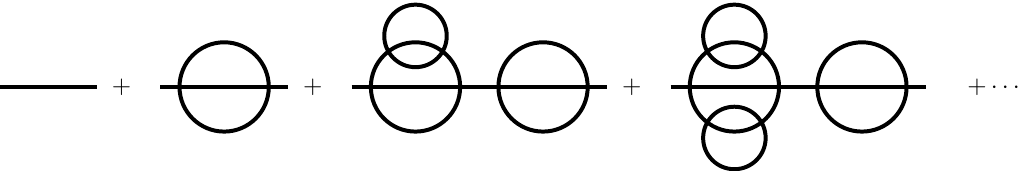
Figure 6. Contributions to two point function in single line notation.